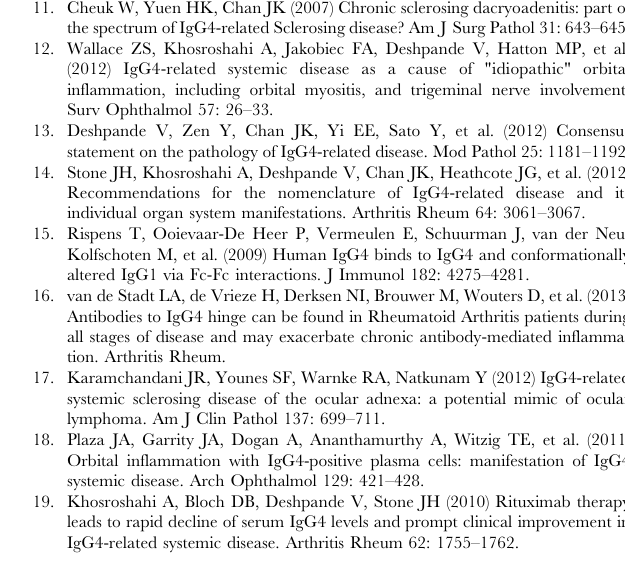
File S1 Figure S1, Representative images illustrating the variability of IgG4 and IgG staining in orbit adipose tissue from subjects with NSOI. Table S1, Comparison of gene expression in IgG4 + and IgG4- orbit adipose tissues. Table S2, Comparison of gene expression in IgG4 + and IgG4- lacrimal gland